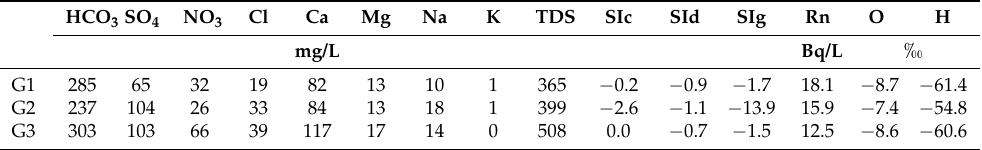
Table 4. The statistical results of clusters for groundwater samples from October.